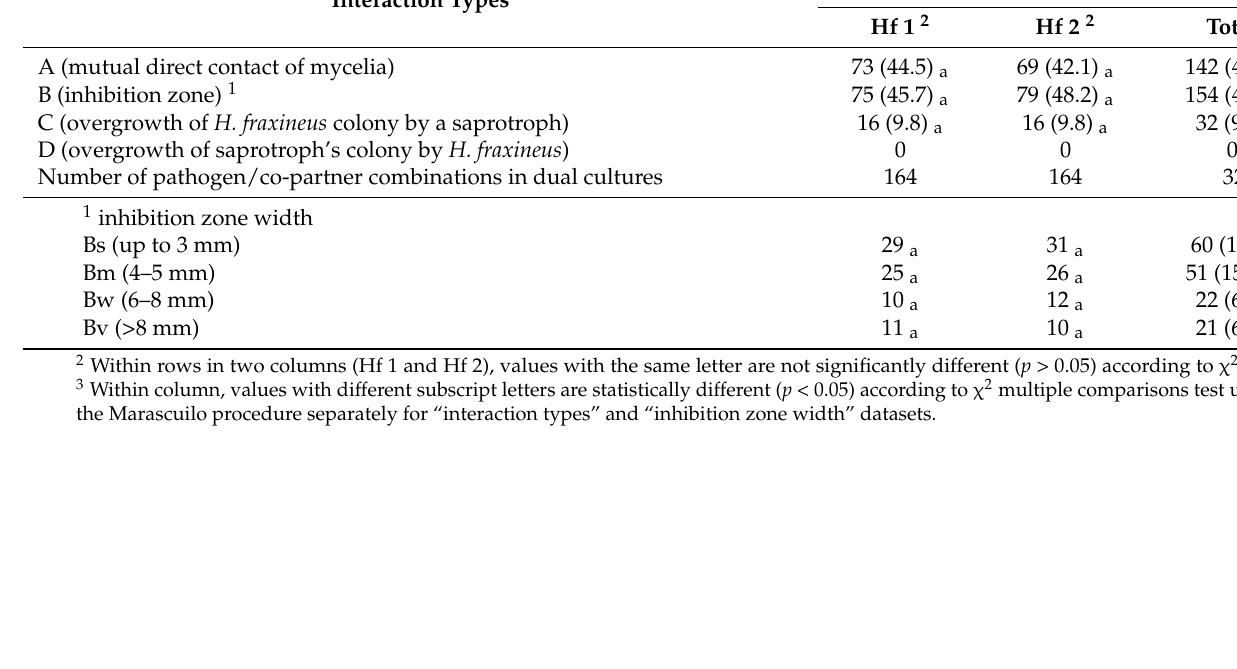
Table 4. Interaction types in dual cultures of H. fraxineus and test fungus from the previous year’s leaf petioles of F. excelsior . Interaction